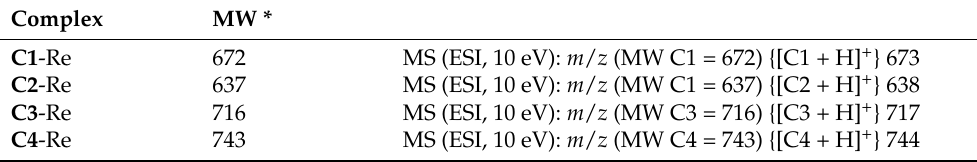
Table 2. MS results of the rhenium analogs of C1 – C4 .